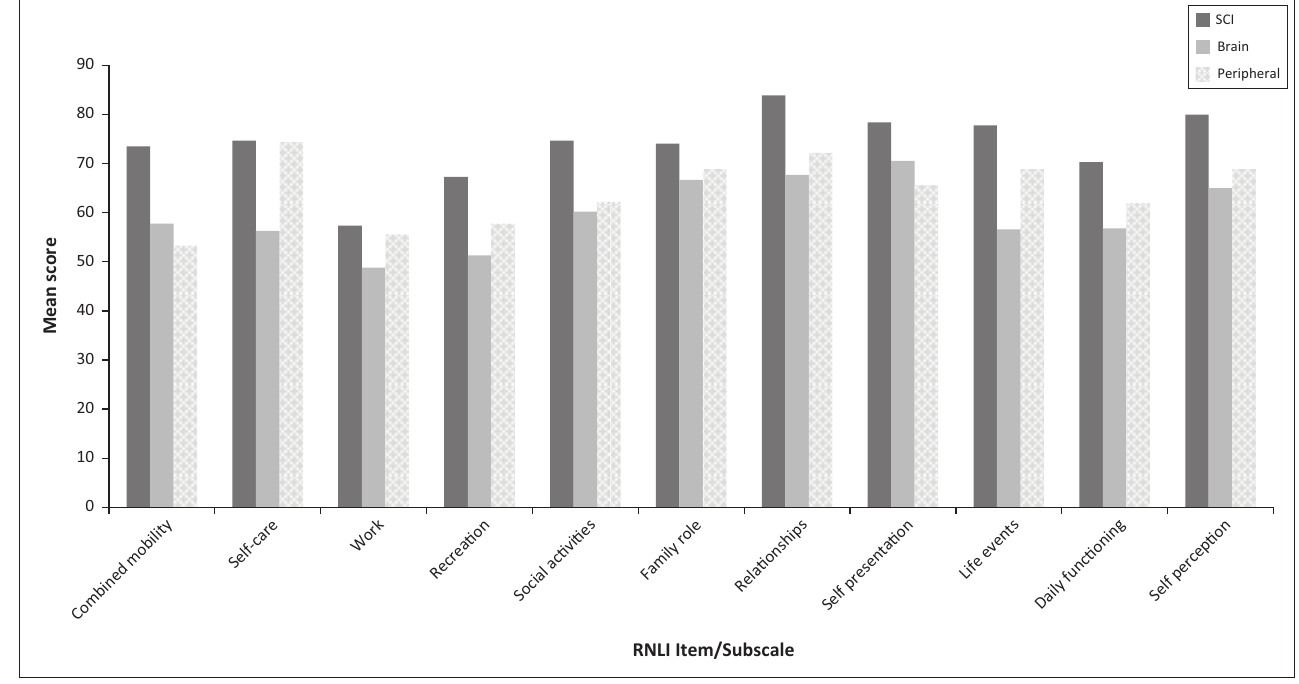
FIGURE 2: Mean Reintegration to Normal Living Index domain scores for the three diagnostic